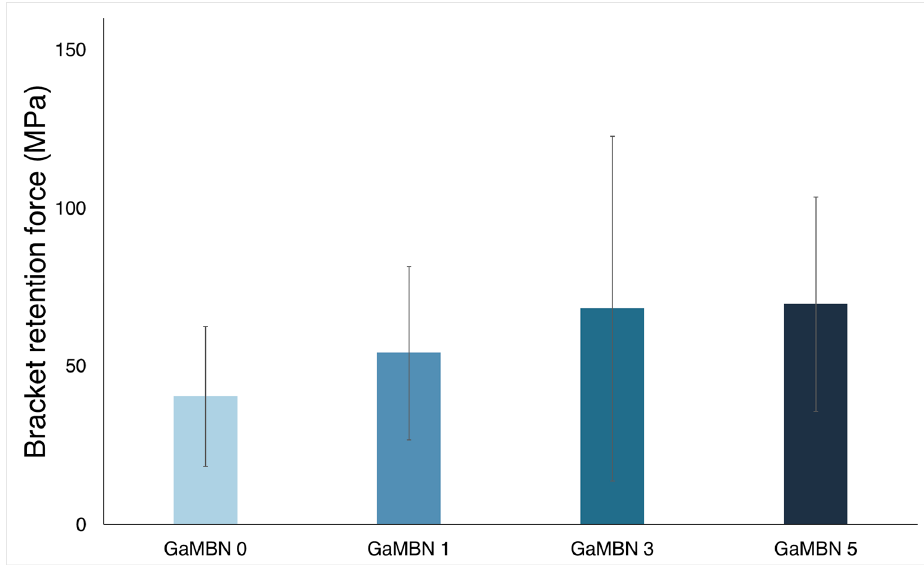
Figure 8. Bracket retention test results of GaMBN-containing resins. Based on one-way ANOVA (p > 0.01), the results of the four GaMBN resins were not significantly different. Error bars represent the standard error (n = 7).